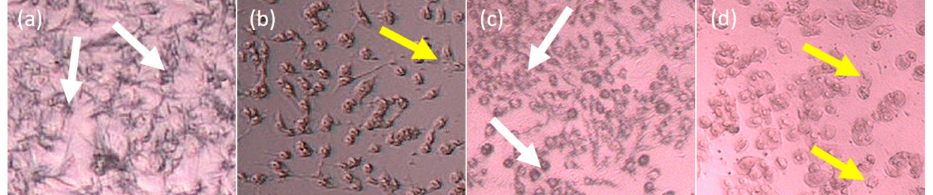
Figure 5. The cell morphologies after and before treatment with IC ethylacetate as follows: ( a ) untreated T47D, ( b ) treated T47D, ( c ) untreated 4T1, and ( d ) treated 4T1. The white arrows indicate the normal living cells that form formazan crystals whereas the yellow arrows indicate the dead cells.